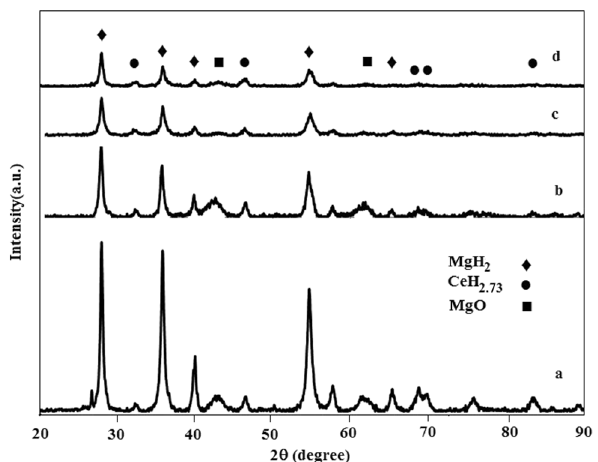
Fig. 11 XRD patterns of MgH 2 -6 wt % of mischmetal ball-milled for a 20, c 30, and MgH 2 -10 wt% of mischmetal ball-milled for b 20 and c 30 h Table 2 Mean crystallite size and lattice strain of the ball-milled MgH 2 -10 wt% and MgH 2 -6 wt% of mischmetal after 20 and 30 h of ball-milling